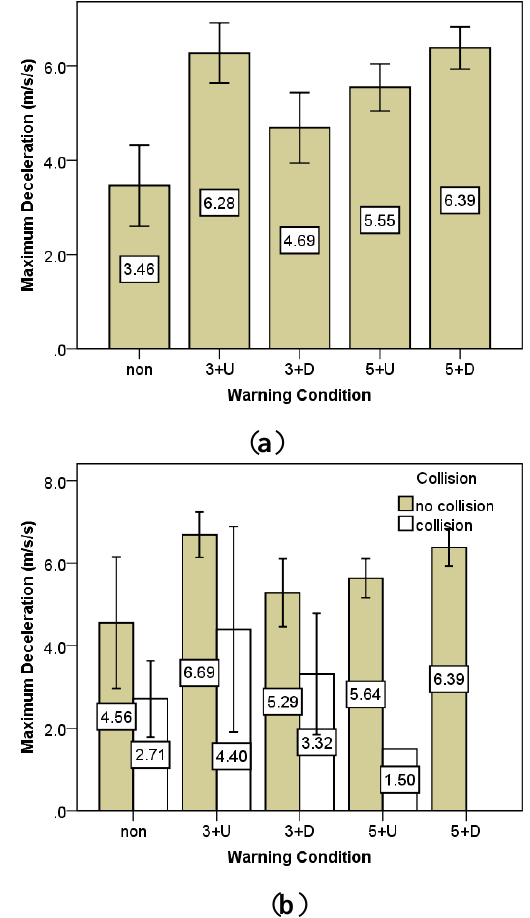
Figure 6. Maximum deceleration comparisons; ( a ) Under different warning conditions. ( b ) According to collisions and without